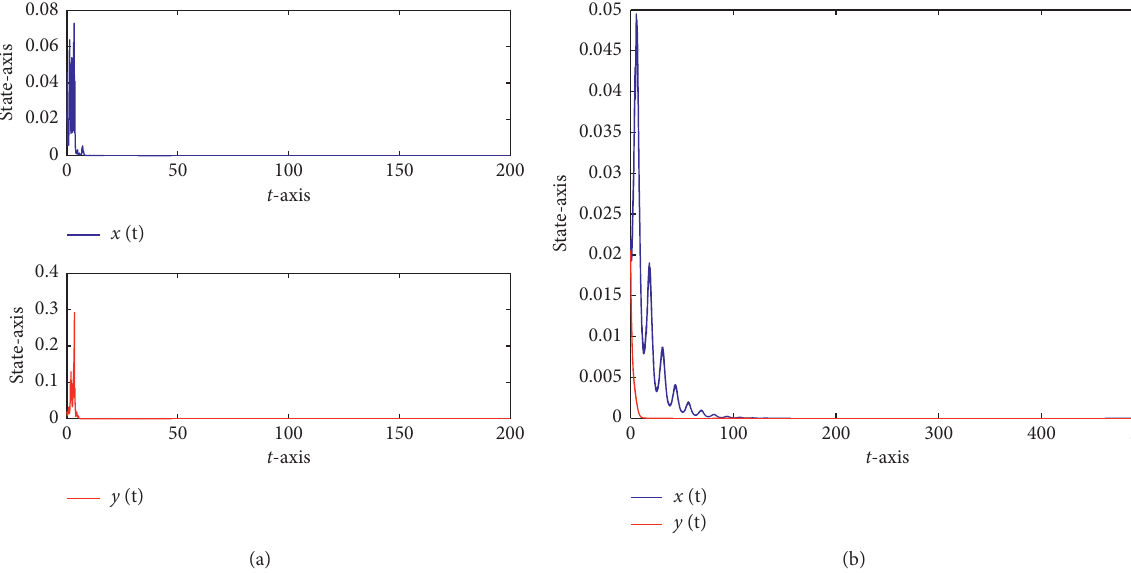
� − 0 . 1 + 0 . 01 sin ( t 1 k